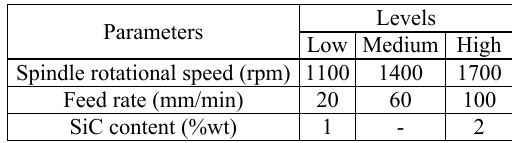
Table 4. The levels of process parameters. Parameters